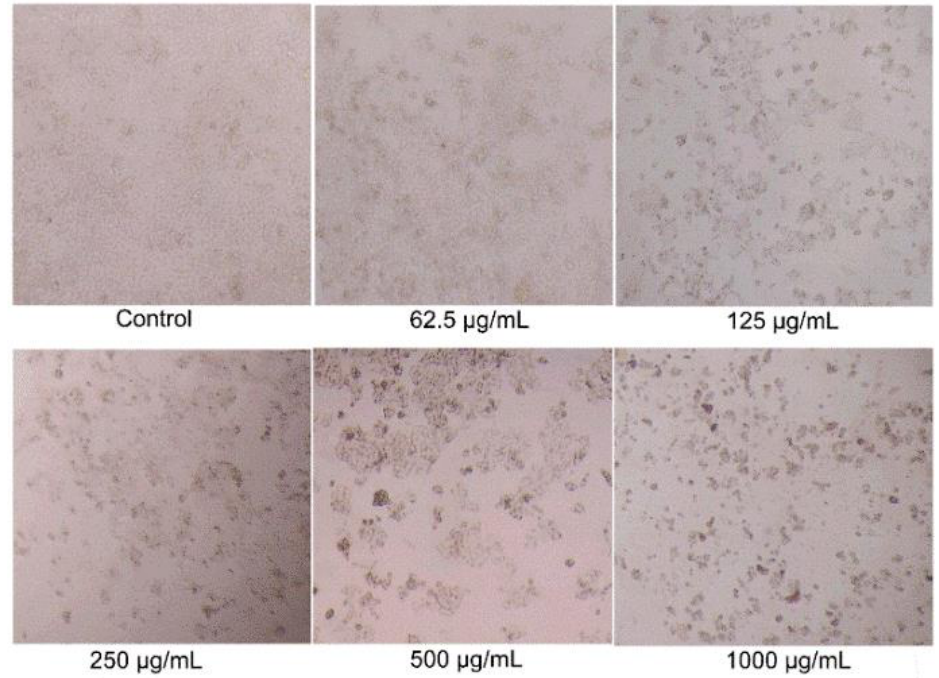
Figure 3. Effects of BSO (black Chenopodium quinoa Wild seed oil) on HCT116 cell morphology. HCT116 cells were treated with different concentrations of BSO for 36 h, and cell morphology was observed and photographed by microscopy (magnification, ×400).